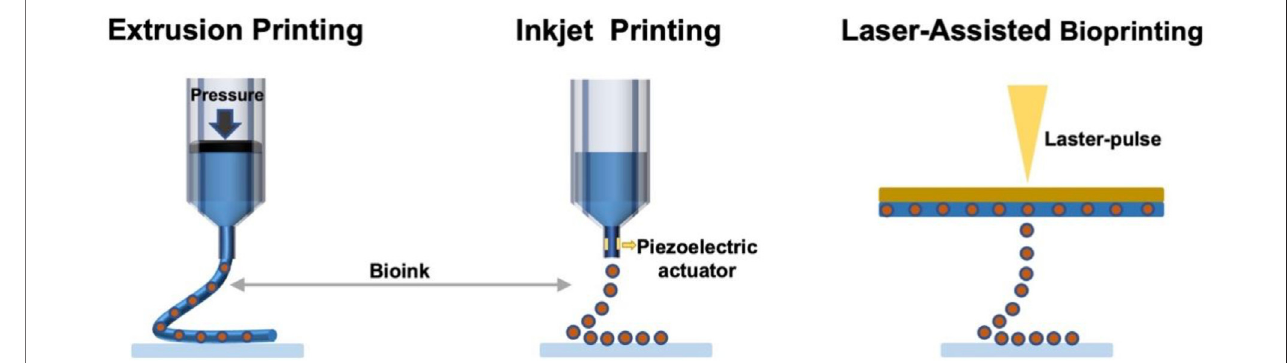
FIGURE 1 | Three categories of 3D printing